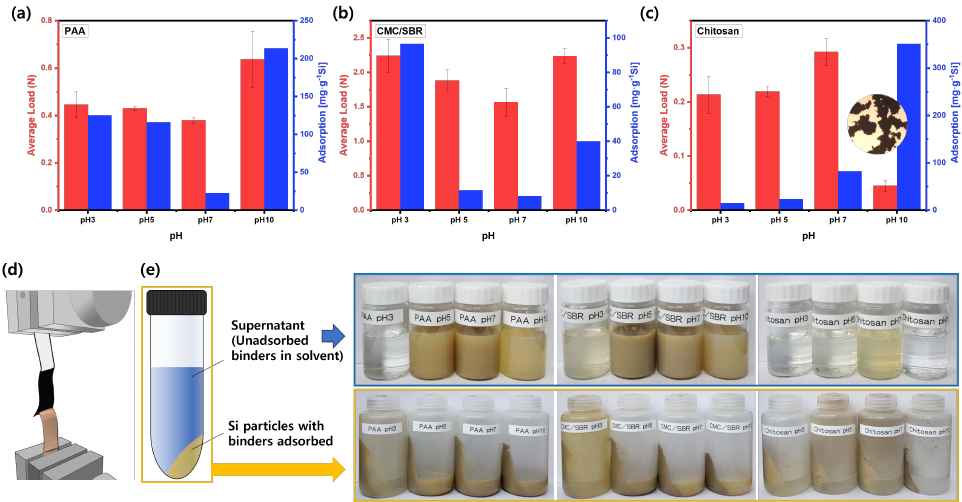
Figure 4. Binder adsorption on Si nanoparticles and adhesion strength of silicon anode slurries with ( a ) PAA binder, ( b ) CMC/SBR binder, and ( c ) chitosan binder on the electrodes. ( d ) Schematic representation of a peeling test and ( e ) silicon anode slurry samples after